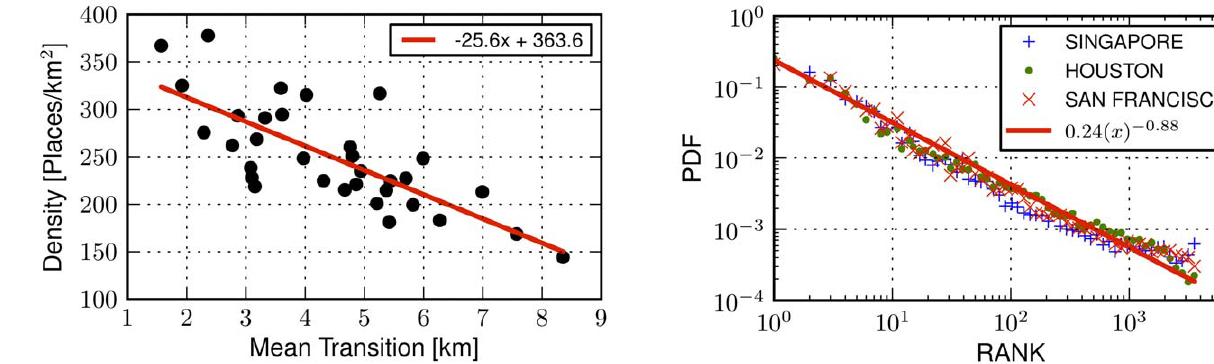
Figure 6. Rank distributions in three cities. (a) Probability density function (PDF) of rank values for three cities (Houston, Singapore and San Francisco). Our methodology to measure the rank distribution is the following: for each transition between two places u and v , we measure rank u ( v ) defined as the number of places that are geographically closer to u than v . We observe that the distributions of the three cities collapse to a single line, which suggests that universal laws can be formulated in terms of the rank variable. The observation confirms the hypothesis that human movements are driven by the density of the geographic environment rather than the exact distance cost of our travels. A least squares fit (red line) underlines the decreasing trend of the probability of a jump as the rank of a places increases.